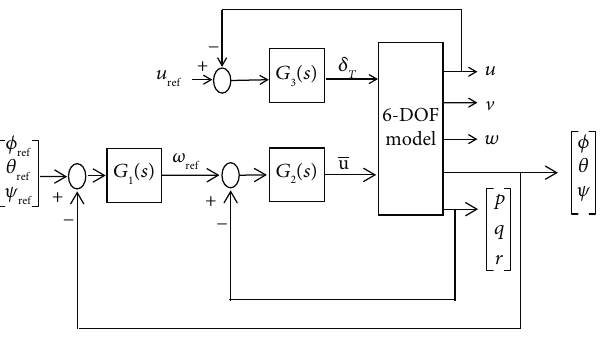
Figure 7: Block diagram of the ACAH system and SCSH system.